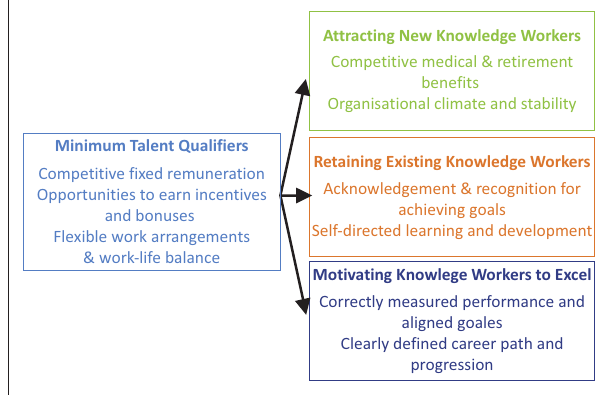
FIGURE 3: Proposed competitive rewards model for information technology knowledge workers in South Africa.